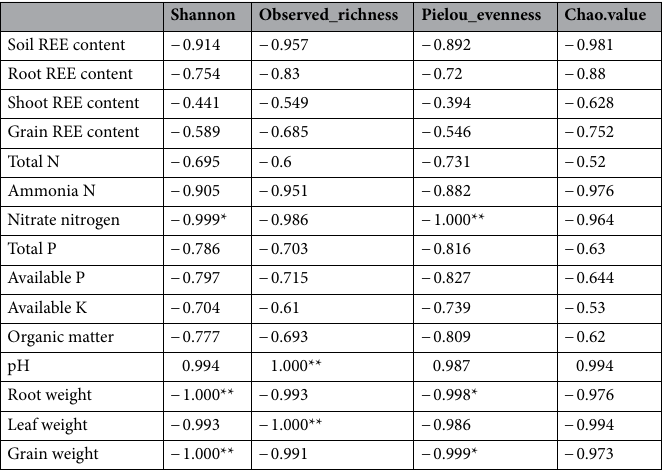
Table 2. Pearson correlation of rare earth element content, soil physical and chemical properties and α-diversity of rice bacteria at maturity stage. **At 0.01 level (two tailed), the correlation was significant, *At 0.05 level (two tailed), the correlation was significant, n =